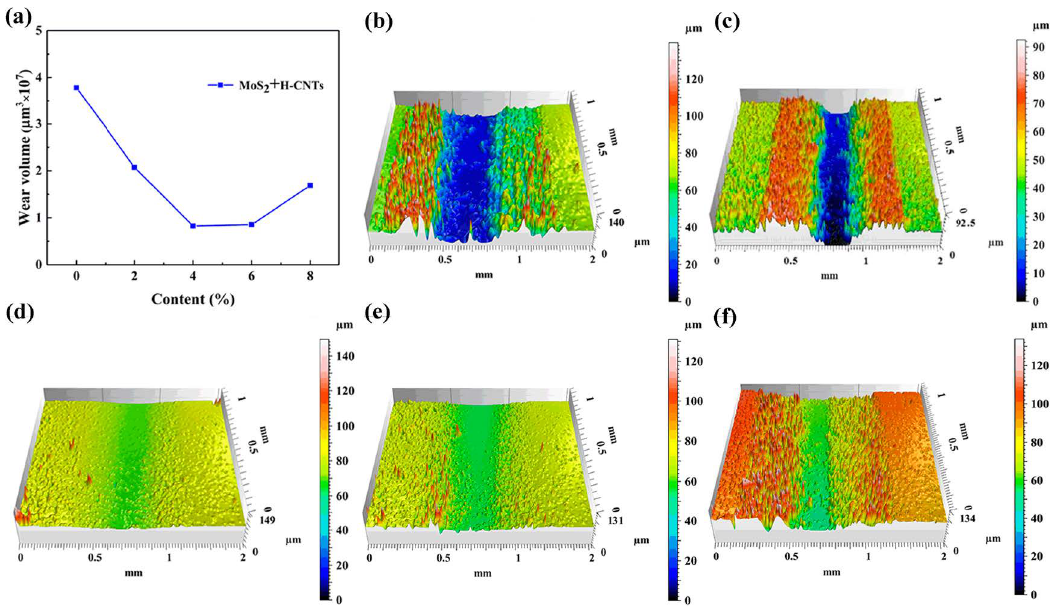
Figure 9. Wear volume curves and 3D wear profile of the original epoxy resin and the epoxy resin composites with different MoS 2 and H-CNTs contents. ( a ) Wear volume curve, ( b ) 6% MoS 2 + 2% H-CNTs, ( c ) 6% MoS 2 +2% H-CNTs, ( d ) 6% MoS 2 + 4% H-CNTs, ( e ) 6% MoS 2 + 6% H-CNTs, and ( f ) 8% H-CNTs.